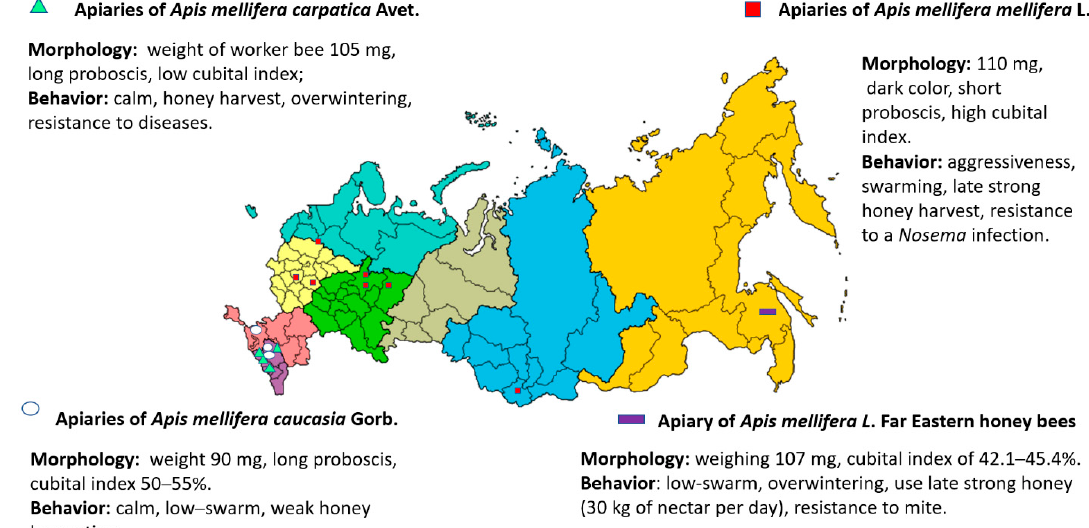
Figure 2. The main breeds of honey bees, locations of certified breeding apiaries, and national parks in the Russian Federation [6,11]. 1, National Park Orlovskiy Polesie (Orlov region); 2, Krasnopolyanskya Experimental Station for Beekeeping (Krasnodarskiy province); 3, ”Maikopskiy” bee-breeding apiary (Republic of Adygea); 4, Selection center “Tatarskiy” (Republic of Tatarstan); 5, Shulgan-Tash State Nature Reserve (Republic of Bashkortostan); 6, Vishersky and Malinovii Hutor national parks (Perm region).